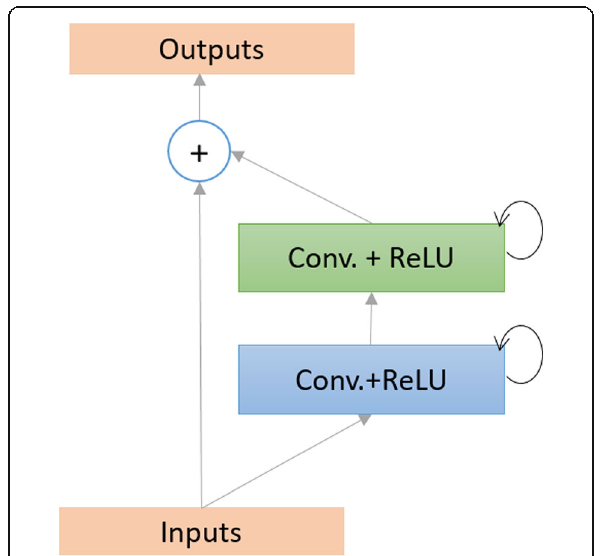
Fig. 5 The recurrent residual unit (RRU) is used for DCRN, R2U-Net, and UD-Net